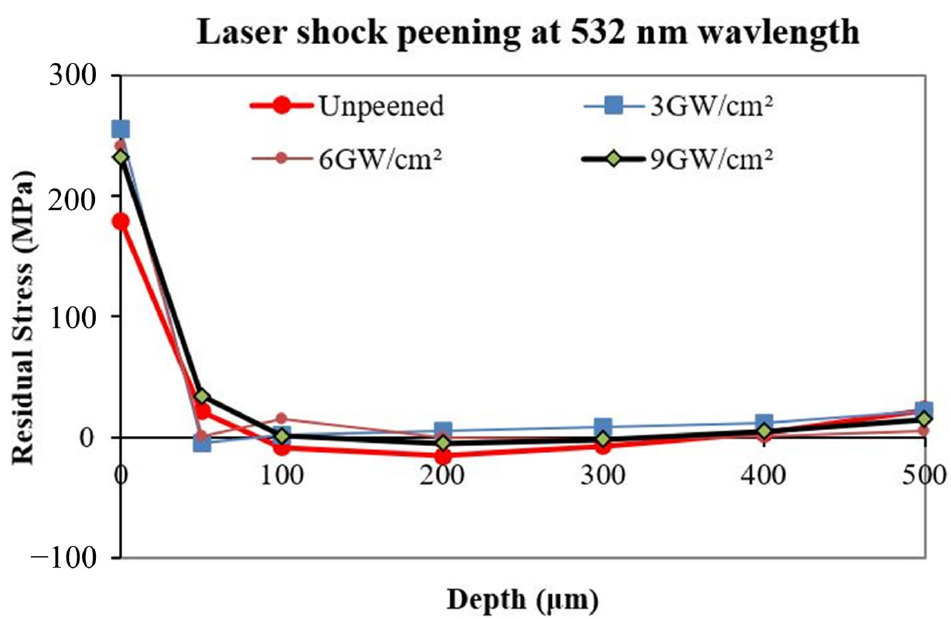
Figure 3. Residual stress distribution profile of LSPwC specimen at 532nm.